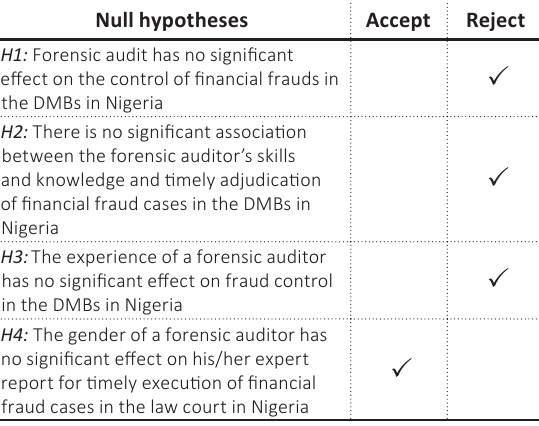
Table 15. Analysis of null hypotheses